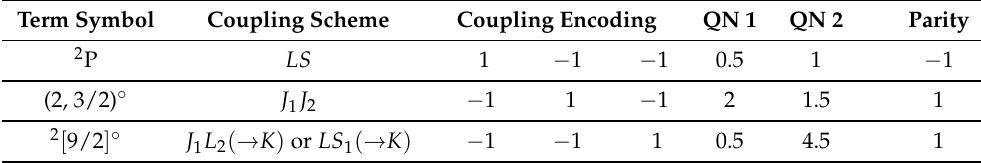
Table 2. Examples of numerical representation for term symbol in each distinguishable NIST coupling notation. Each coupling type is numerically encoded with a unique one-hot scheme. QN 1 and QN 2 represent the two respective quantum numbers that couple to give